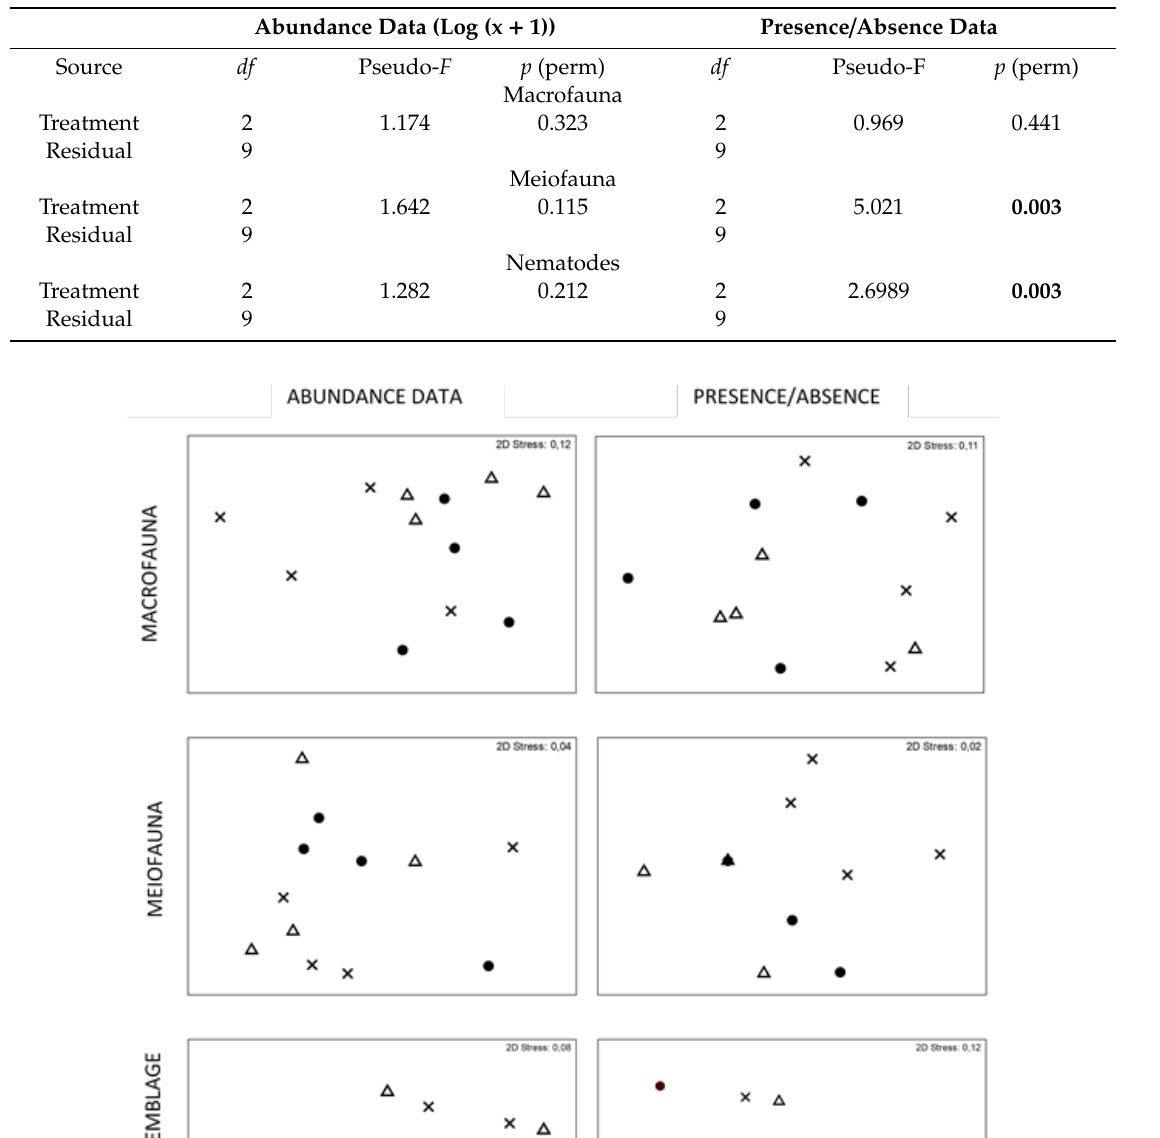
Table 2. Di ff erences in multivariate structure of macrofauna, meiofauna and nematode assemblages between substrates using PERMANOVA. Bold values indicate p < 0.05.